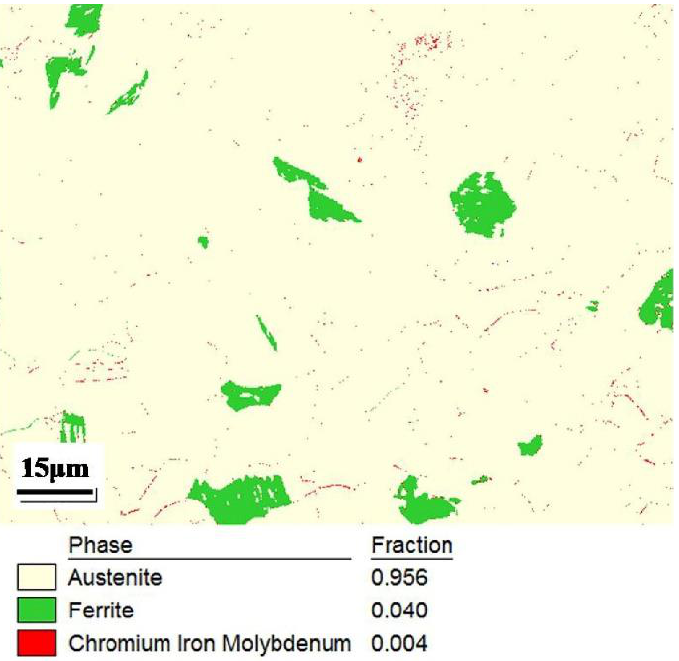
Figure 3. EBSD results of phase distribution map with the ferrite in green, σ phase in red, and austenite matrix in canary as shown by the color coding. Reprinted with permission from [12], Copyright 2020 Elsevier.